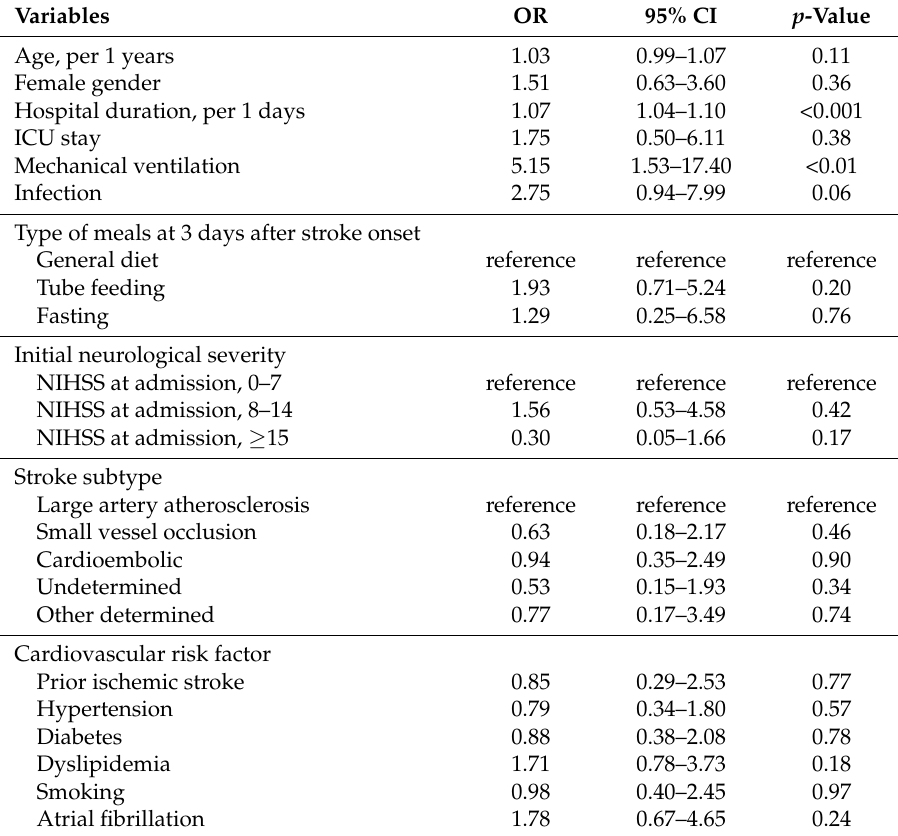
Table 2. Binary logistic regression for prescription of escitalopram. 1,2